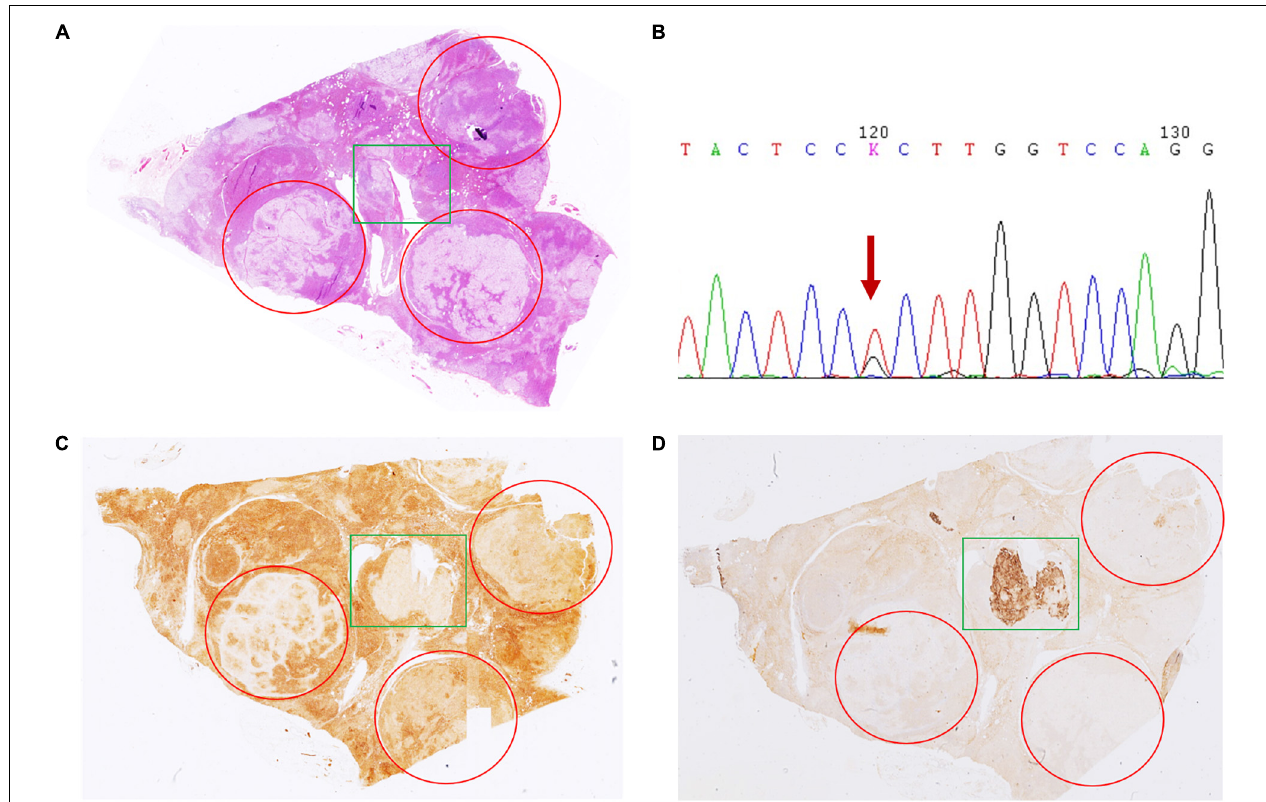
FIGURE 1 | Hematoxylin and eosin (H&E) and immunohistochemical staining of CYP11B1 and CYP11B2 in case 4. (A) Innumerable nodules with intensive hyperplasia of the gland with 3 well-demarcated nodules by 0.4, 0.5, and 0.6 cm in diameter independently (marked by red circles). Irregular zone with CYP11B1 (C) weak staining and CYP11B2 (D) strong expression (marked by green rectangles). Irregular zone with CYP11B2 strong expression harbored KCNJ5 mutation of 503 (168) T > G (B)